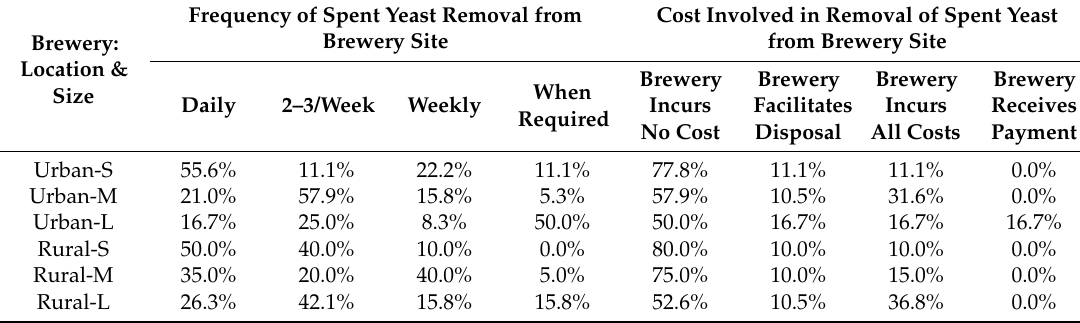
Figure 4. Spent yeast disposal method in urban and rural based craft breweries. ( A ) Urban-based craft brewers; ( B ) Rural-based craft breweries. Black bars: breweries with a batch capacity smaller than 1000 L; red bars: breweries with a batch capacity greater than 1000 L, but smaller than 2000 L; and green bars: breweries with a batch capacity greater than 2000 L. Total figures might add up to over 100% because some breweries employ multiple methods of disposal. Table 2. Frequency of spent yeast removal and costs incurred, by brewery location and